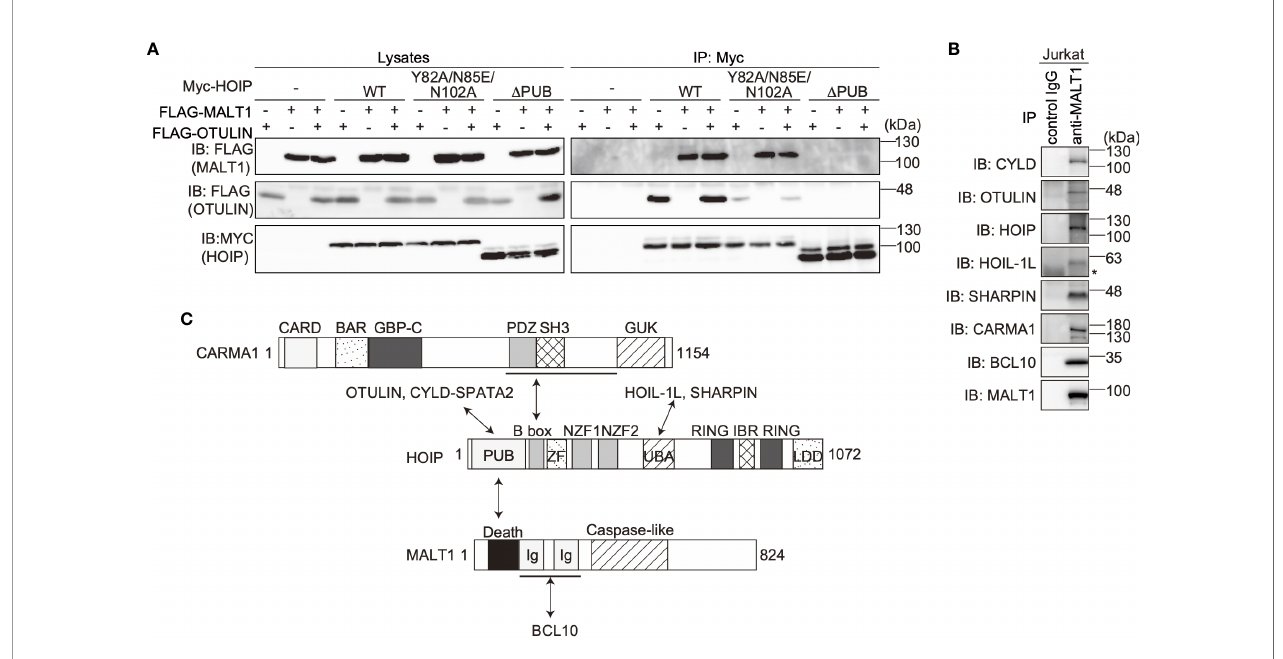
FIGURE 3 | OTULIN and MALT1 simultaneously bind to the PUB domain of HOIP. (A) WT and various mutants of Myc-HOIP were co-expressed with FLAG-MALT1 and/or FLAG-OTULIN in HEK293T cells, as indicated. Cell lysates and anti-Myc immunoprecipitates were immunoblotted with the indicated antibodies. (B) The endogenous association of CYLD, OTULIN, LUBAC, and the CBM complex. Jurkat cell lysates were immunoprecipitated with normal mouse IgG or anti-MALT1 antibody, and subjected to immunoblotting by the depicted antibodies. *; nonspeci fi c signal. (C) Schematic illustration of the LUBAC/DUBs-CBM complex